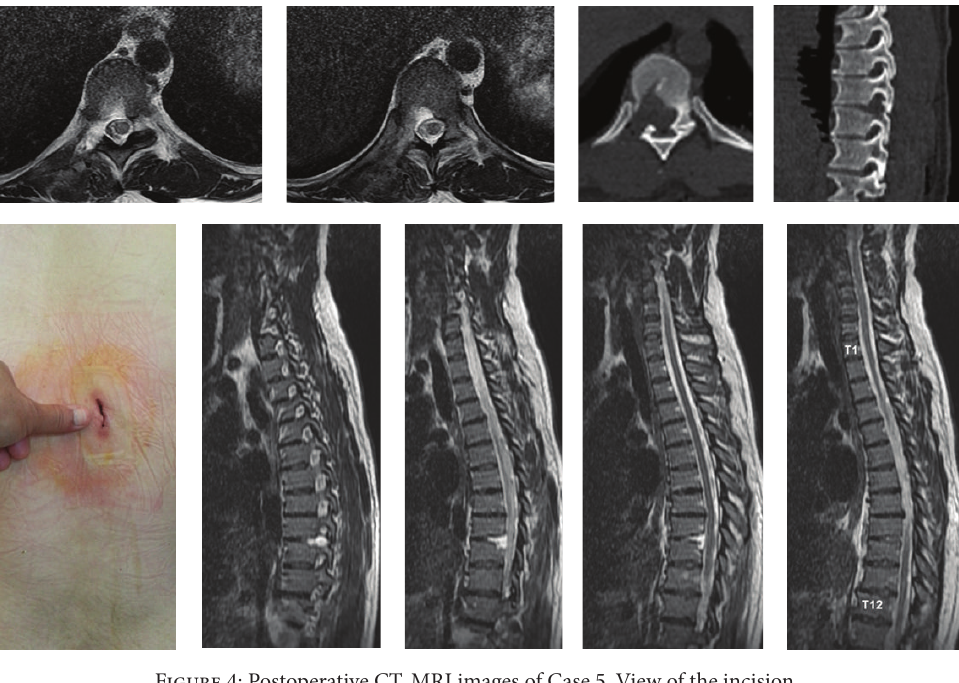
Figure 4: Postoperative CT, MRI images of Case 5. View of the incision.